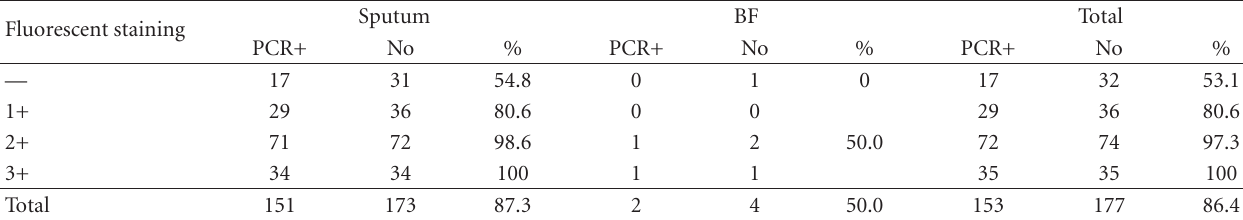
Fluorescent staining